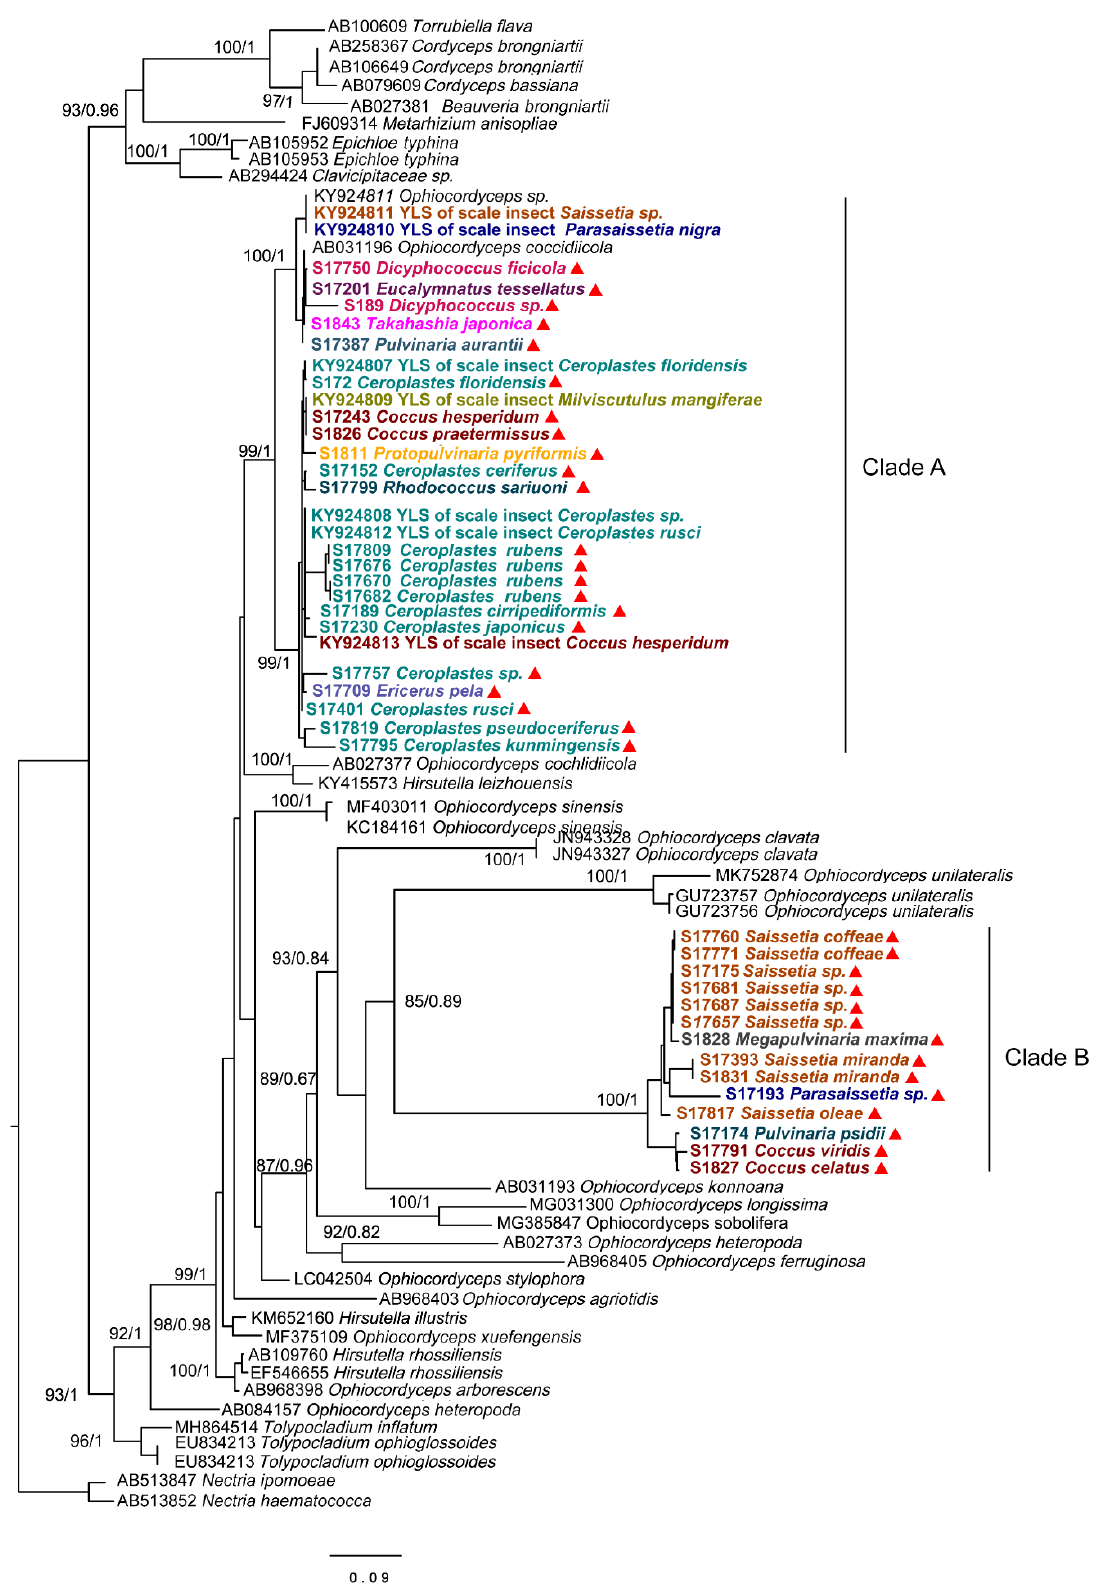
Figure 4. Phylogenetic analysis of the Ophiocordyceps fungi based on an (about) 800 bp fragment of partial ITS gene. Bayesian inference (BI) and maximum likelihood (ML) trees had similar topology. The bootstrap support values and posterior probabilities are indicated for each node. Support values below 70 are not shown. The samples in this study are labeled with red triangles. Different colors represent species from different genus.